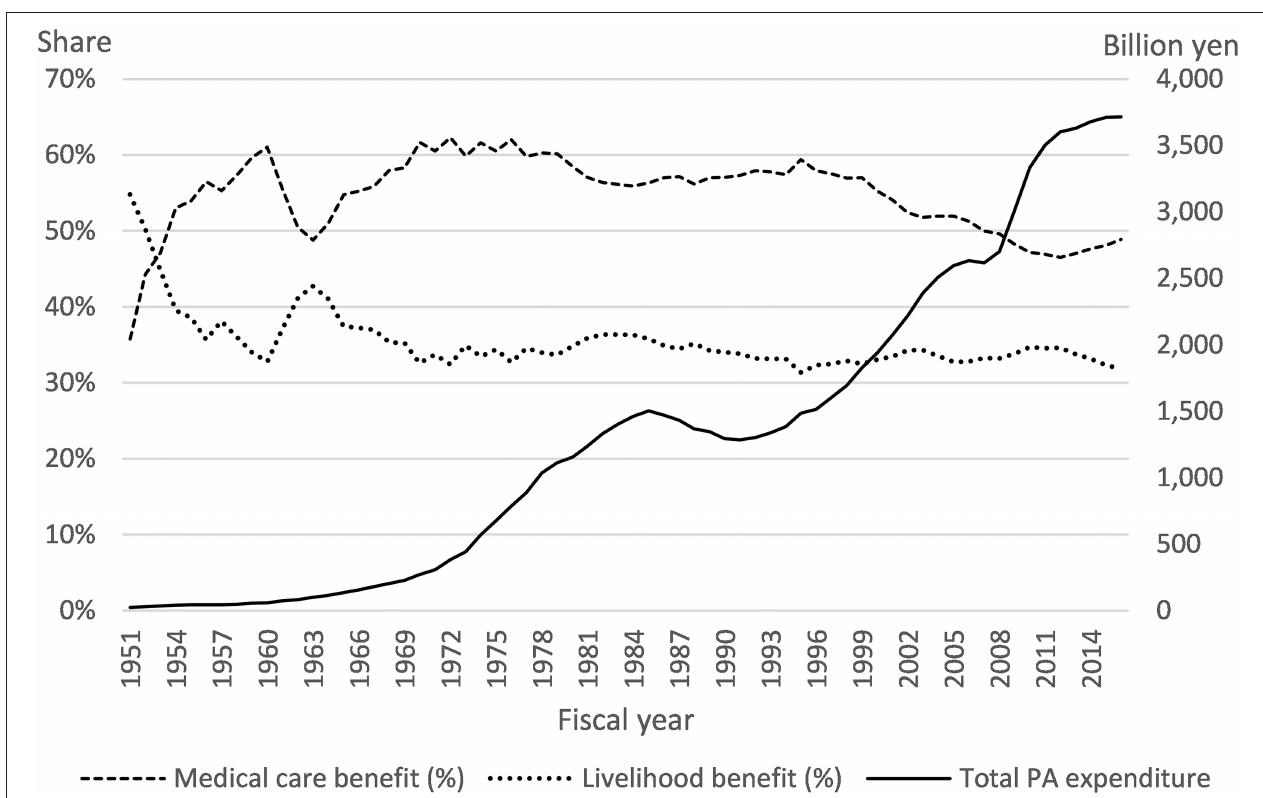
FIGURE 1 | Trends in public assistance expenditures and shares of medical and livelihood benefits. Source from the Annual Report on Social Security Statistics , the General Administrative Agency of the Cabinet (1959–2000), and National Institute of Population and Social Security Research